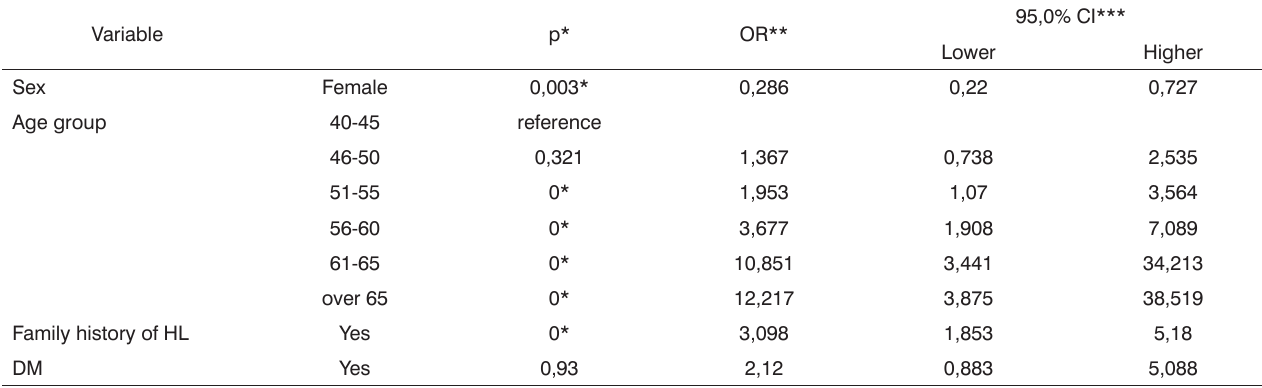
Table 4. Variables selected in the logistics regression model and the results.